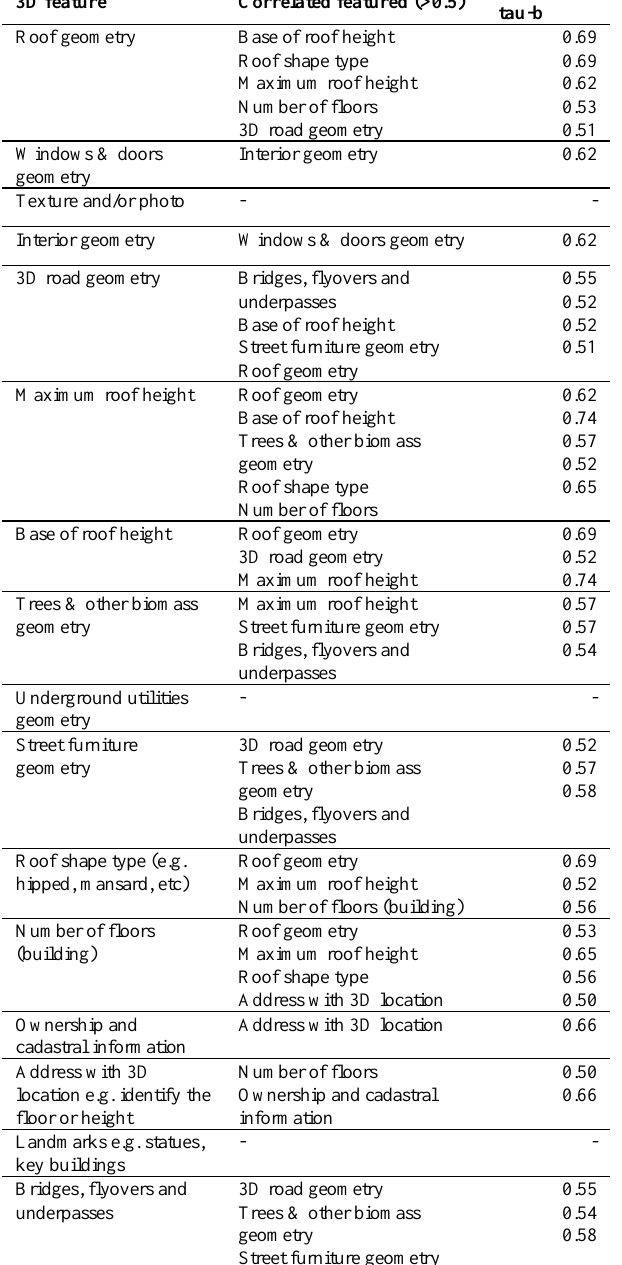
Table 2. Summary table of features with a Kendall’s tau-b >0.5, sorted in descending order.